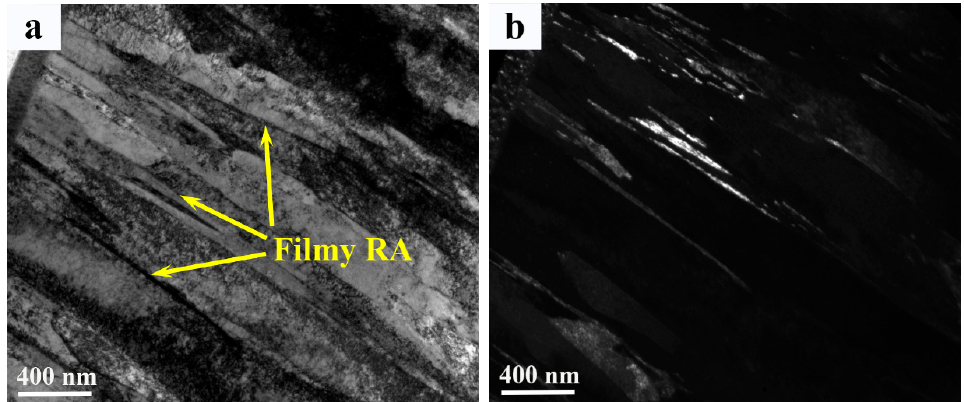
Figure 6. Microstructure of weld metal; ( a ) OM image of weld metal; ( b ) SEM image of weld metal; and ( c ) Magnified SEM image of red square area in ( b ).